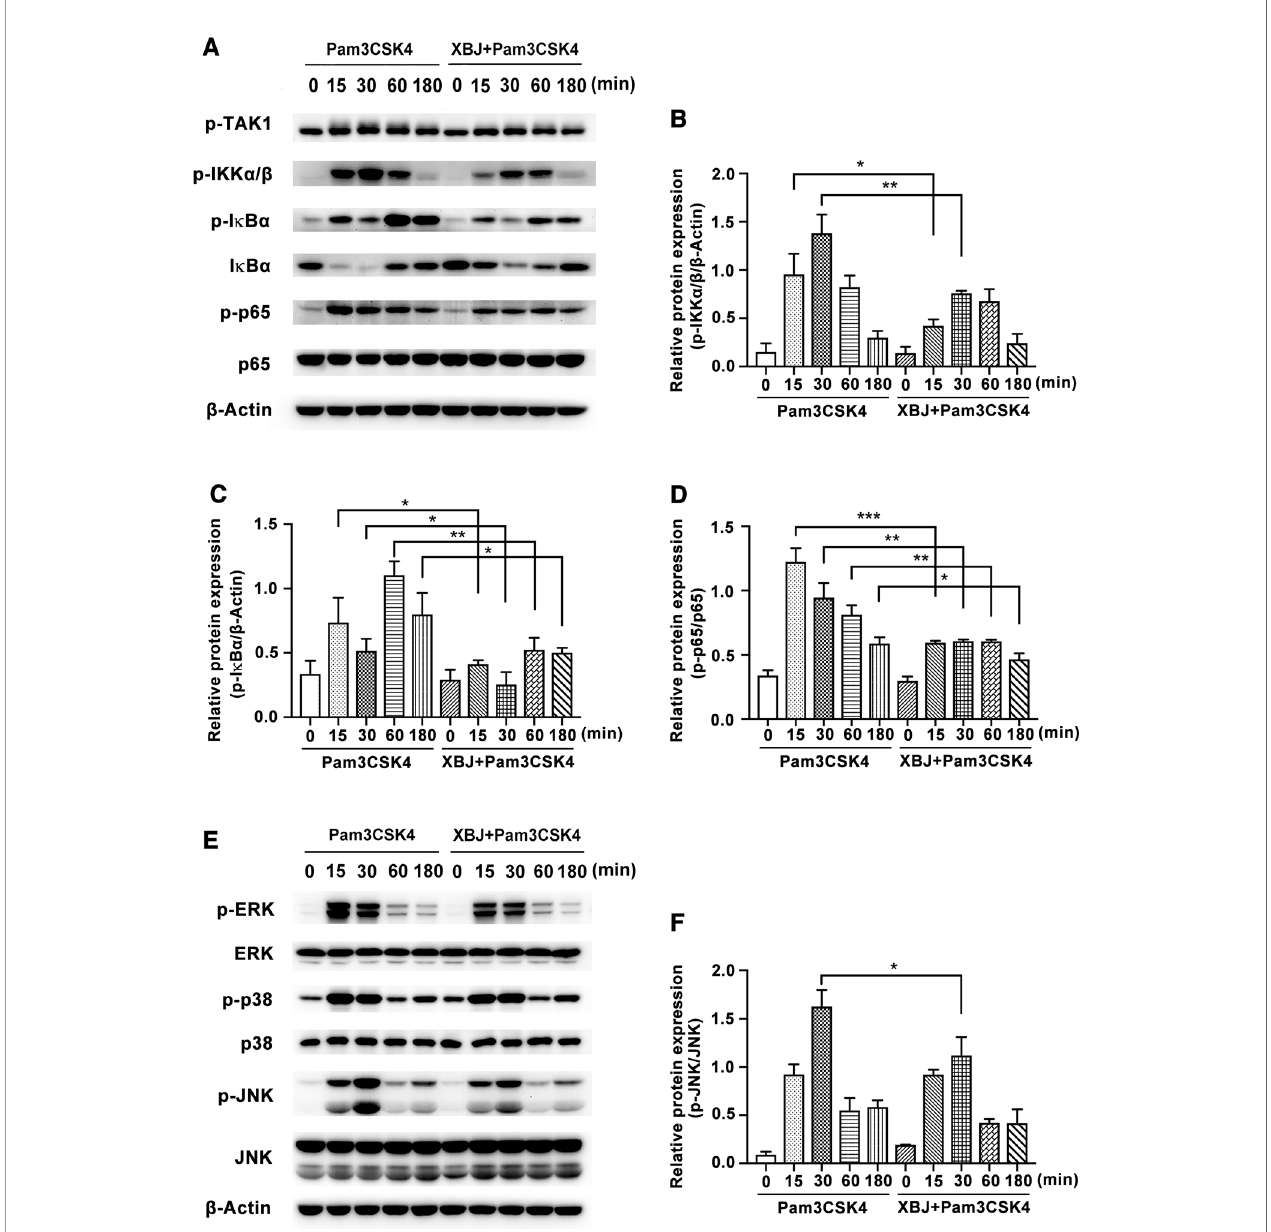
FIGURE 8 | XBJ inhibited Pam3CSK4-induced activation of NF- k B and MAPK pathways. Mouse primary peritoneal macrophages (1× 10 6 cells/well) were plated overnight, and then stimulated with Pam3CSK4 (100 ng/ml) in the presence or absence of XBJ (10 m l/ml) for different time periods. (A, E) The phosphorylation of signal proteins of NF- k B and MAPK pathway were examined by Western blot with the reference of the corresponding total proteins. The bar graphs showed the statistical results for the relative quantitative expression of p-IKK a / b (B) , p-I k B a (C) , p-p65 (D) and p-JNK (F) expression. Data were shown with the means ± SD of at least three independent experiments. * , ** , ***Signi fi cantly different at p < 0.05, p < 0.01, and p < 0.001,